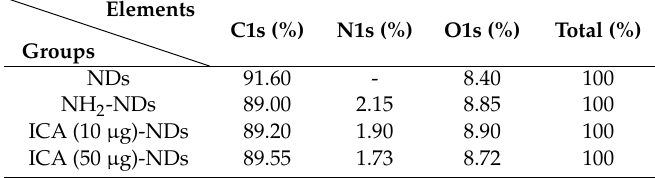
Table 1. Elemental compositions of unmodified NDs and modified NDs by XPS analysis. Elements C1s Groups